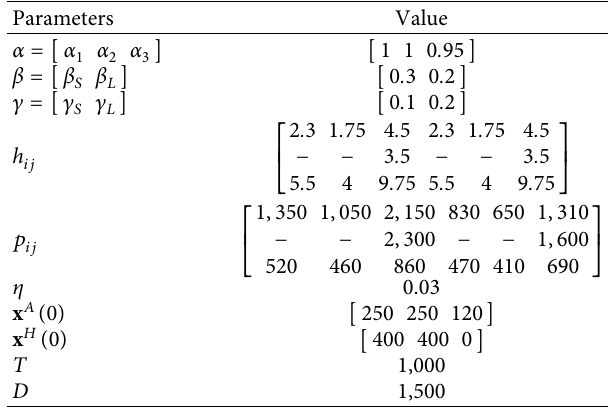
Table 6: Parameters used in DCCM.